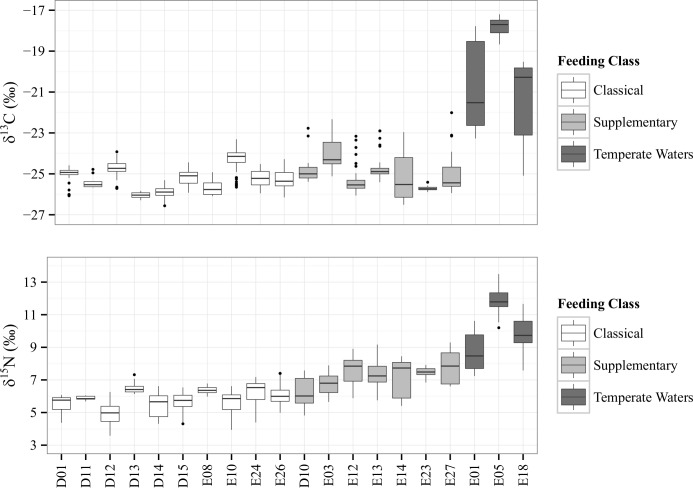
Boxplot representation of each individual whale according to feeding category.Representations of the spread of values for each individual baleen plate, with colours assigned as per feeding category. Boxes represent the 25th and 75th quartiles and are sectioned by the mean. Whiskers represent the 95th quartiles, with outliers as dots.